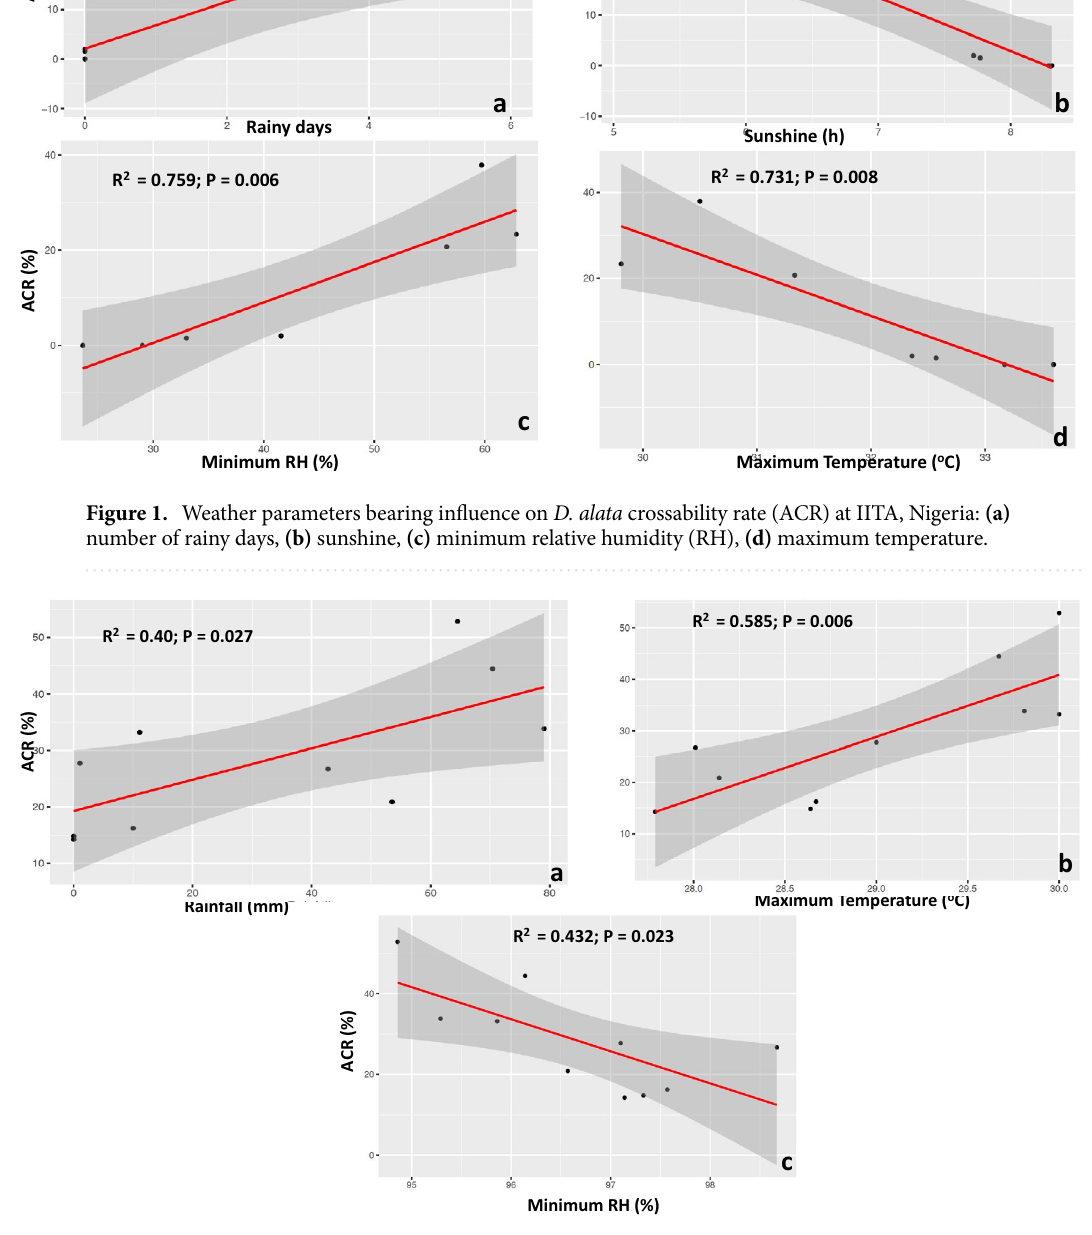
Figure 2. Weather parameters bearing influence on D. rotundata crossability rate (ACR) at IITA, Nigeria: (a) rainfall, (b) maximum temperature, (c) minimum relative humidity